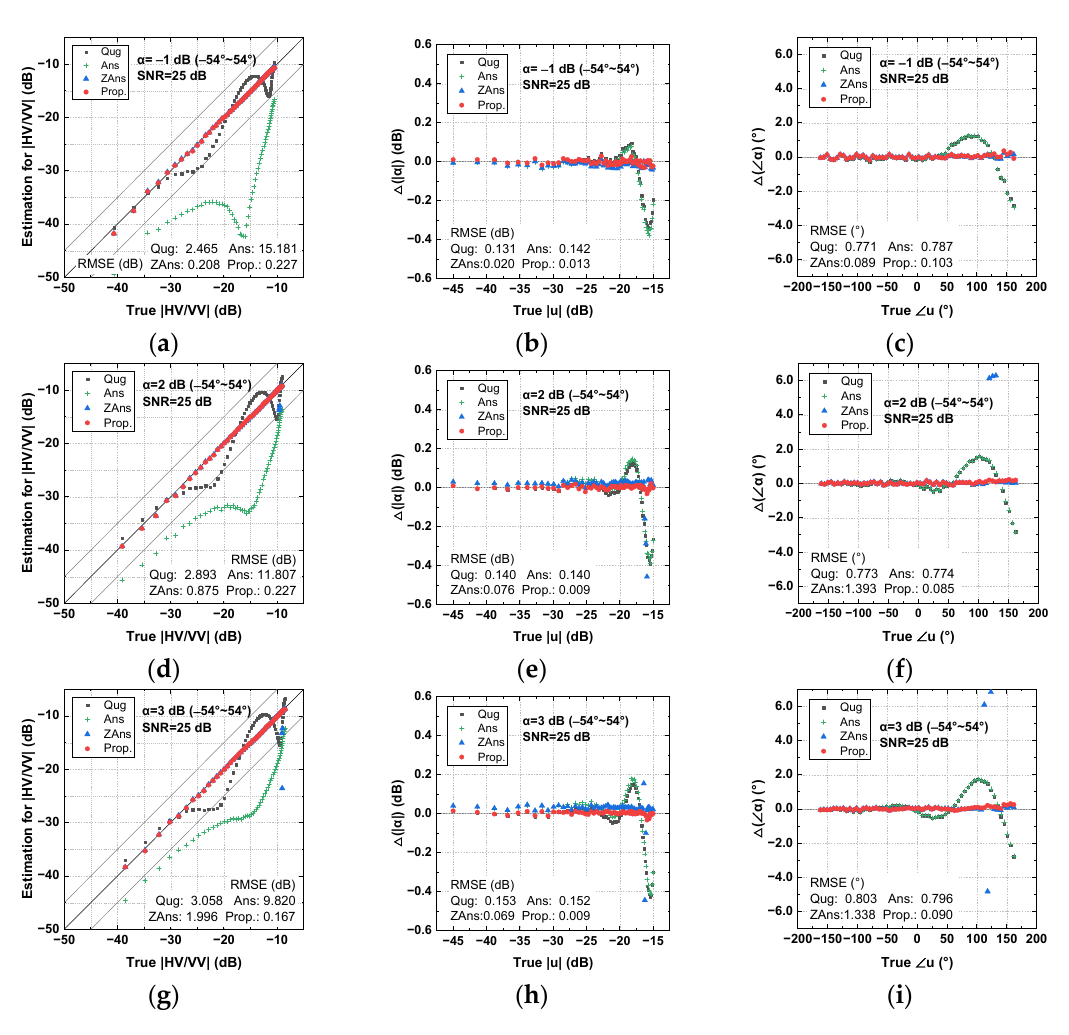
respectively. The horizontal axis represents the true level of HV/VV in amplitude and crosstalk in simulations. The RMSE accuracy calculations are shown at the bottom of each image.